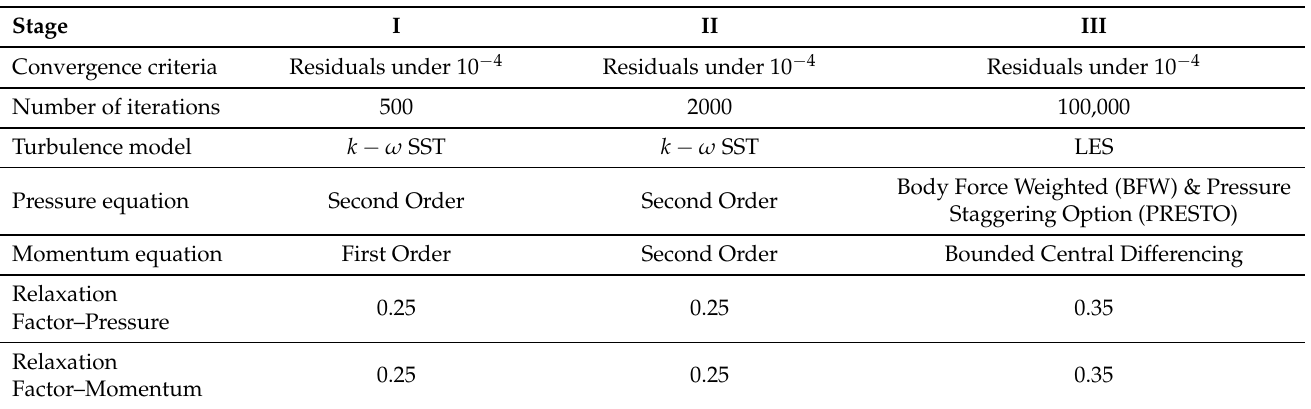
Table 3. Convergence criteria, adopted parameters and the mathematical models used for the numerical